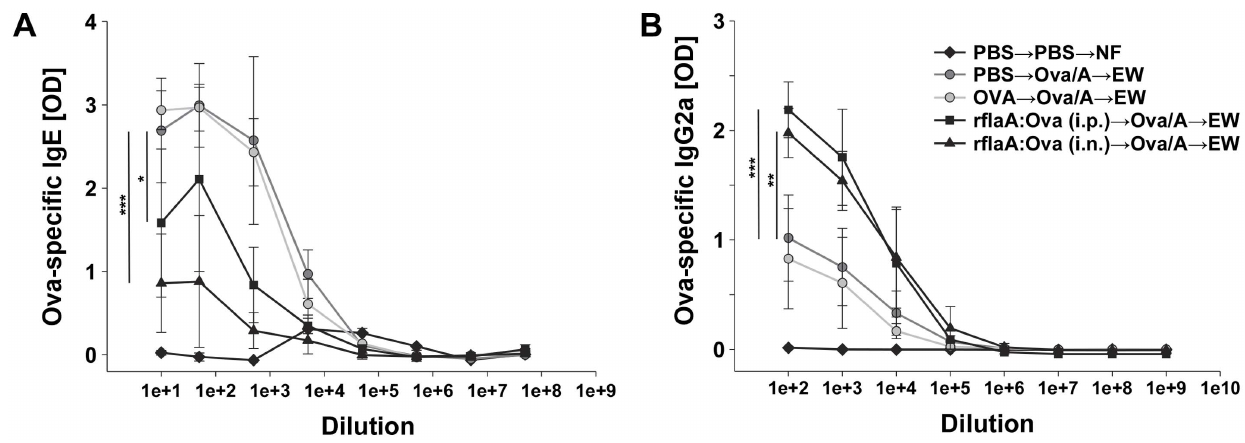
Figure 2. Prophylactic vaccination with rflaA:Ova induces IgG2a and suppresses IgE production. Sera of control (PBS R PBS R NF) and Ova-sensitized, EW-challenged mice (Ova/A R EW) were collected at the end of EW-pellet feeding (day 36) and analyzed for Ova-specific IgE ( A ) and